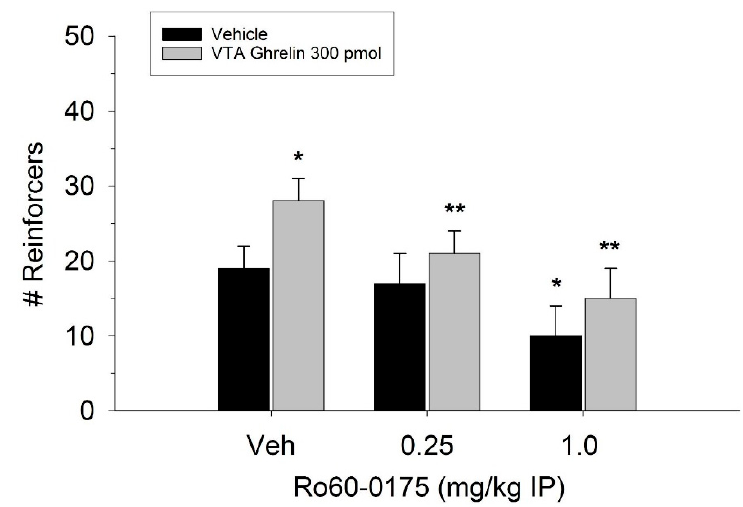
Figure 4. Systemic administration of the 5-HT 2c agonist Ro60-0175 attenuated the effect of VTA ghrelin on operant responding for food reward. Data are presented as mean number of reinforcers ± SEM; n = 8. * p < 0.05 compared to vehicle (Veh). ** p < 0.05 compared to ghrelin administered with saline pretreatment.